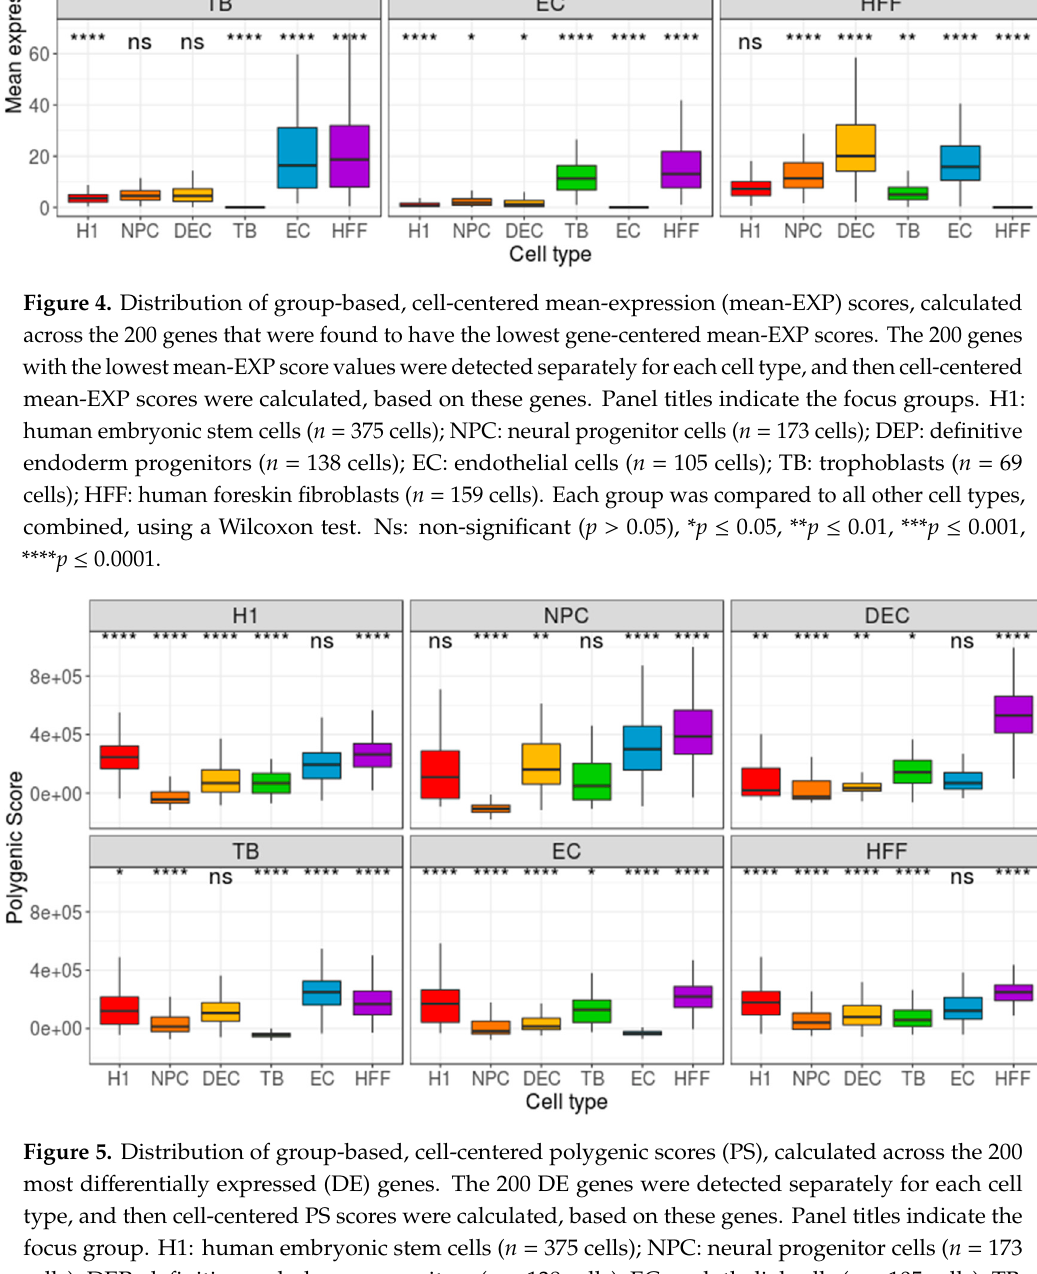
Figure 5. Distribution of group-based, cell-centered polygenic scores (PS), calculated across the 200 most differentially expressed (DE) genes. The 200 DE genes were detected separately for each cell type, and then cell-centered PS scores were calculated, based on these genes. Panel titles indicate the focus group. H1: human embryonic stem cells ( n = 375 cells); NPC: neural progenitor cells ( n = 173 cells); DEP: definitive endoderm progenitors ( n = 138 cells); EC: endothelial cells ( n = 105 cells); TB: trophoblasts ( n = 69 cells); HFF: human foreskin fibroblasts ( n = 159 cells). Each group was compared to all other cell types, combined, using a Wilcoxon test. Ns: non-significant ( p > 0.05), * p ≤ 0.05, ** p ≤ 0.01, *** p ≤ 0.001, **** p ≤ 0.0001.